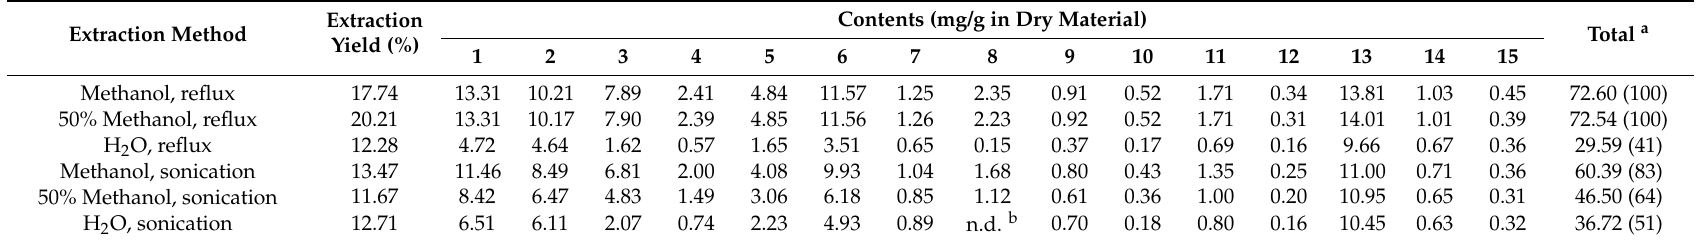
Table 1. Extraction efficiency of stilbenoids ( 1 – 13 ) and dihydroisocoumarins ( 14 and 15 ) from the bark of Shorea roxburghii . Extraction Method